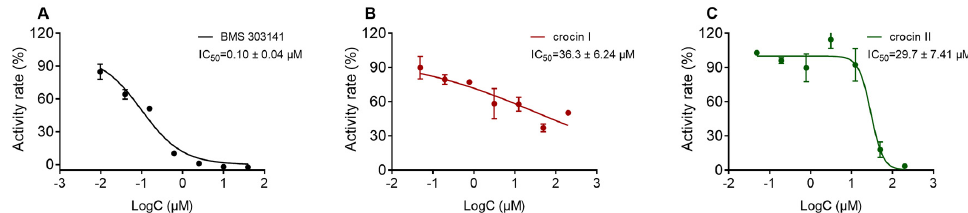
Figure 5. Inhibitory curves of crocins I and II on ACLY. ( A ) Effect of positive control BMS 303141. ( B , C ) Effects of compounds 1 (crocin I) and 2 (crocin II), respectively, on the catalytic activity of ACLY with multiple